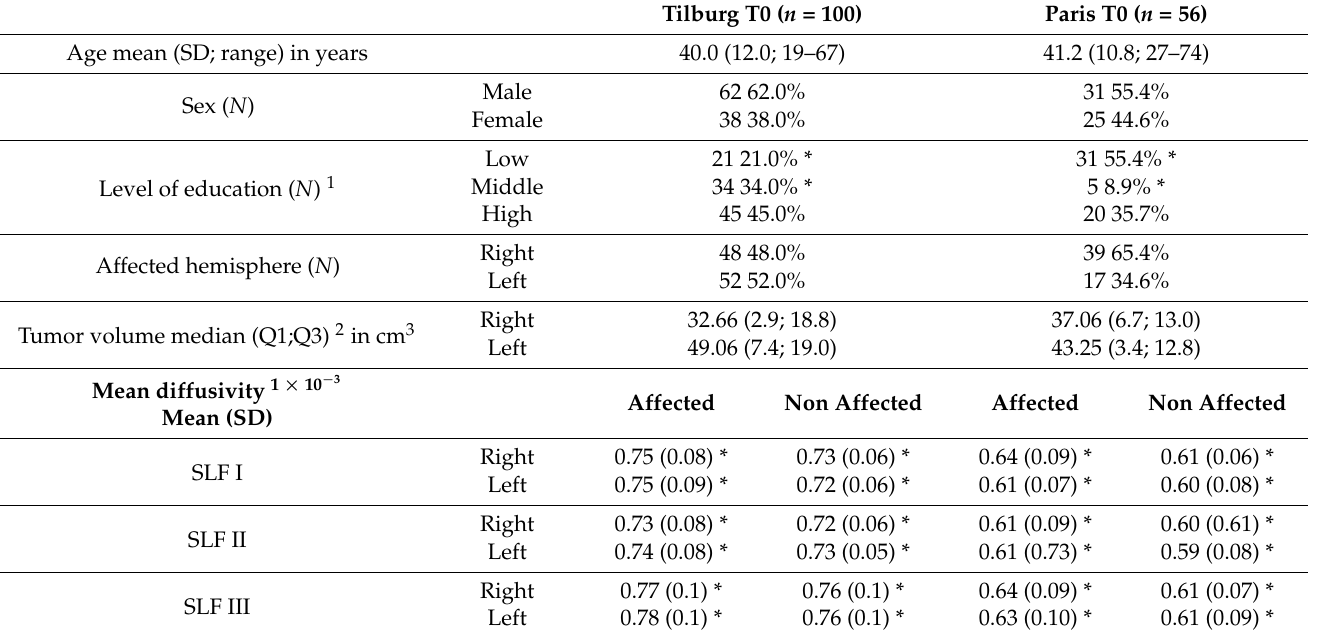
Table 1. Patient characteristics ( n =